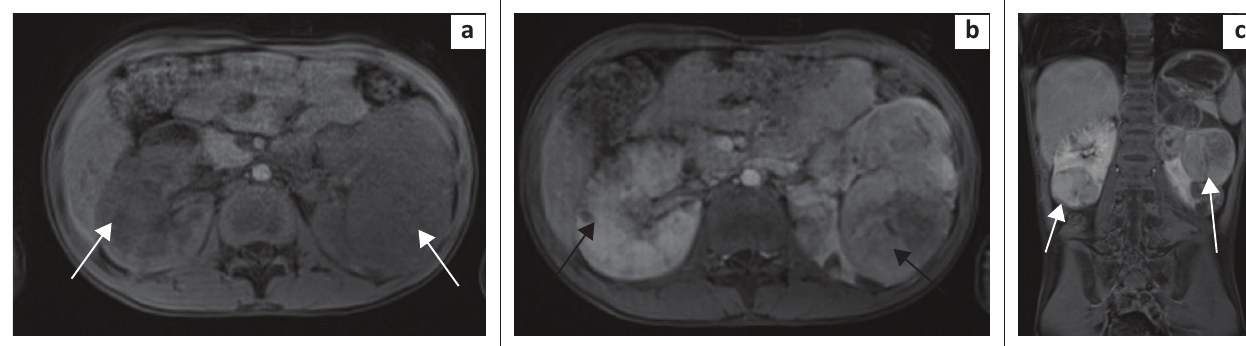
FIGURE 4: (a) T1-weighted axial abdomen demonstrates bilateral iso-intense renal mass lesions (white arrows). (b) T1-weighted axial abdomen post-contrast demonstrated enhancement of the bilateral renal mass lesions (black arrows). (c) T1-weighted coronal abdomen post-contrast demonstrates enhancement of bilateral renal mass lesions (white arrows).